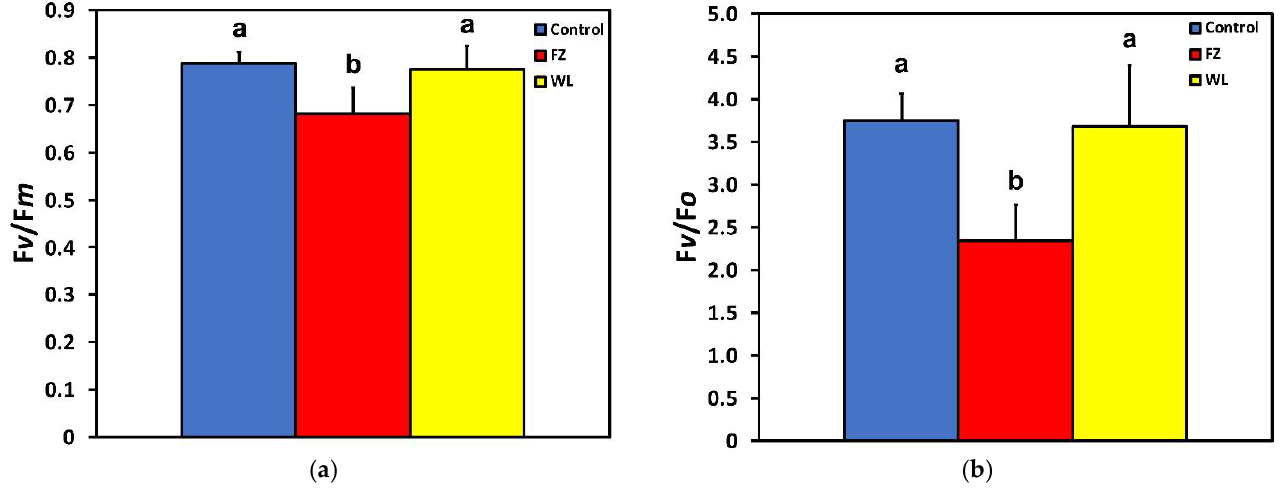
Figure 4. Changes in ( a ) the maximum efficiency of PSII photochemistry (F v /F m ) and ( b ) in efficiency of the water-splitting complex on the donor side of PSII (F v /F o ) at the whole leaflet level before feeding (control), at the feeding zone after feeding (FZ), and at the whole leaflet after feeding (WL). Error bars are standard deviations. Columns with different letters are statistically different ( p < 0.05).